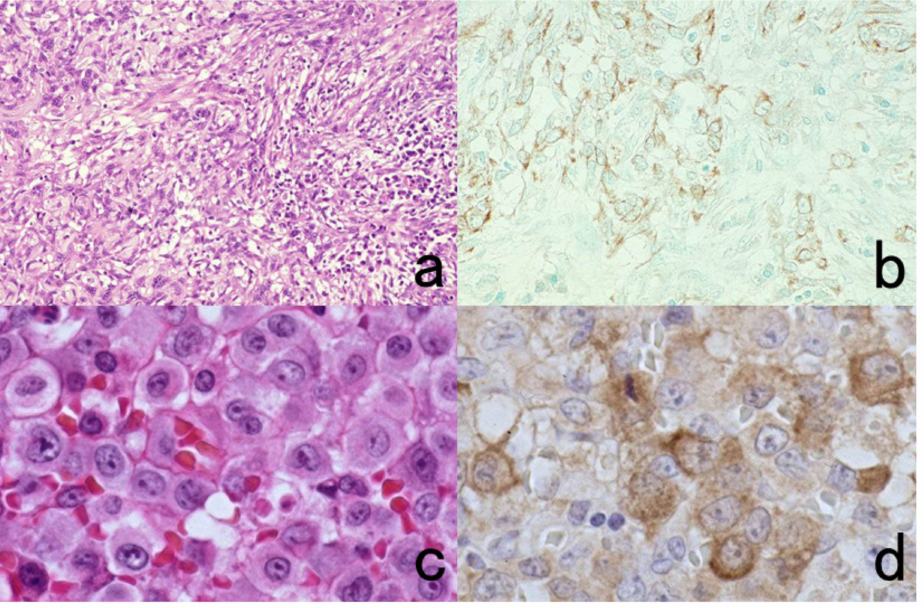
Figure 51. Diagnostic utility and pitfalls of cytokeratin immunostaining. Top panels ( a , b ): Spindle cell carcinoma of the skin and Bottom panels ( c , d ): anaplastic large cell (Ki-1) lymphoma . Left panels ( a , c ): H&E and Right panels ( b , d ): immunostaining with wide-spectrum anti-cytokeratin antiserum. Cytokeratin expression confirms the epithelial nature of the spindle cells in the skin. Because of the epithelioid morphology and cytokeratin expression in Ki-1 lymphoma, diagnostic confusion with metastatic undifferentiated carcinoma may occur. The nuclei in panel ( b ) are counterstained with methyl